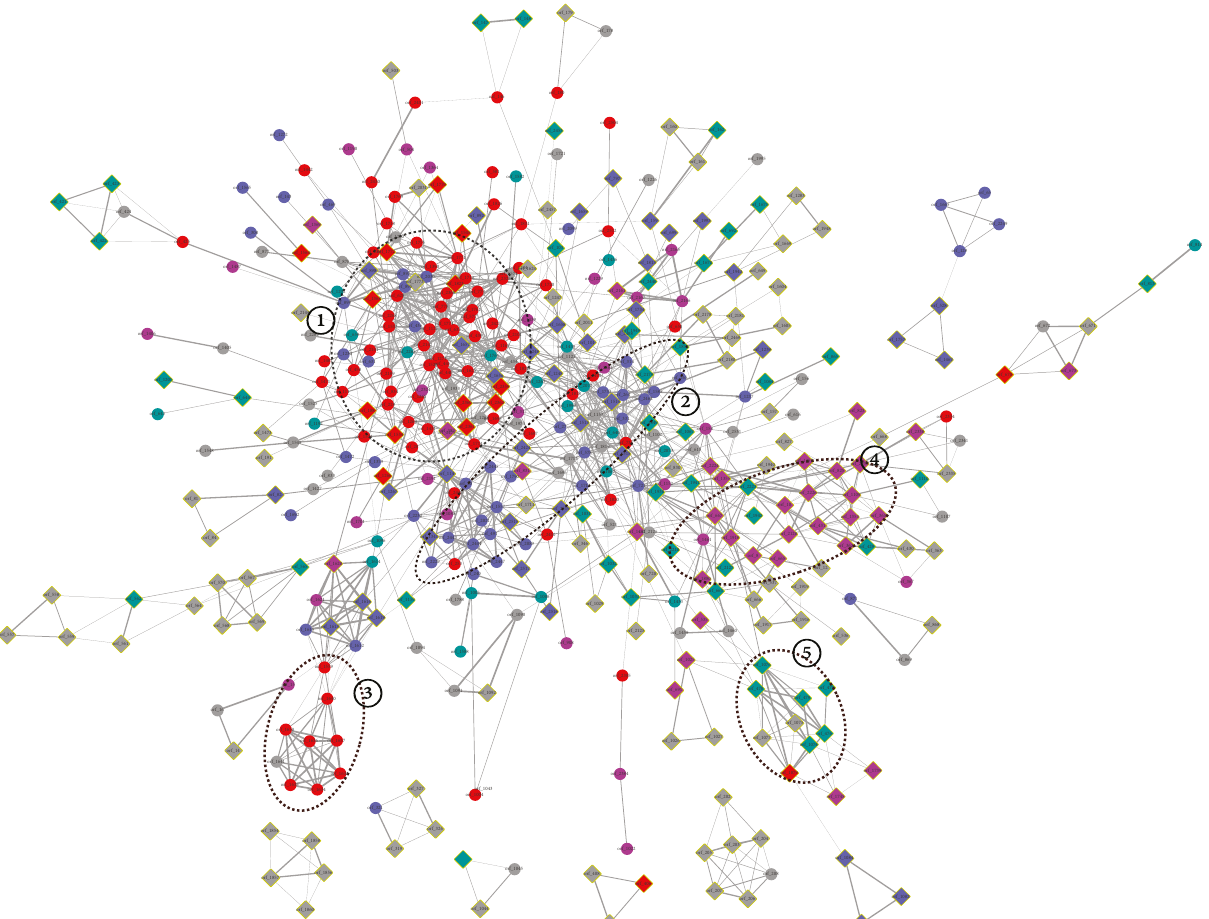
Figure 7: Protein-protein interaction of UGNP and UGNGS. N. gonorrhoeae 32867 genome is used as reference. The names of nodes correspond to Table S1. Circular nodes represent the UGNP proteins, and diamond nodes with yellow margin represent the UGNGS proteins. Only the networks with the number of nodes greater than 3 were shown. The network edges represent the protein-protein associations, and their line thickness indicates the con fi dence of the association between corresponding nodes. The disconnected nodes are hidden in the map. Di ff erent colors re fl ect di ff erent protein function categories: red: basic substance transport and metabolism; purple: genetic information processing, including replication, transcription, and translation; blue: cellular processes, including cell wall/ membrane/envelope biogenesis and cell motility; green: bacteria-environment interaction, including signal transduction, extracellular structures, and defense mechanism; grey, function